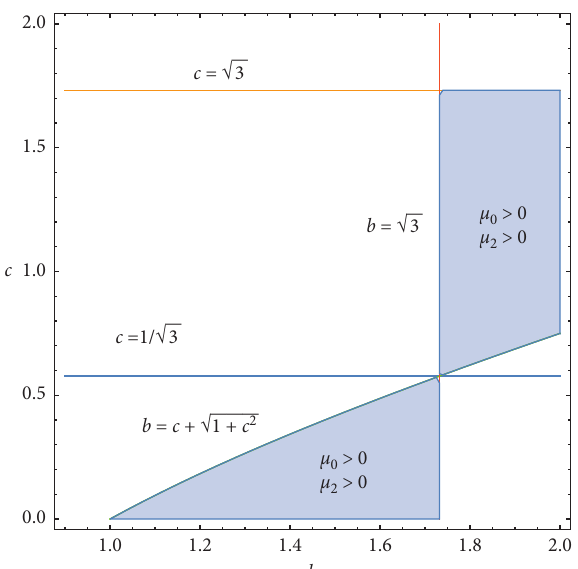
Figure 7: Region of existence of central configuration for the concave kite four-body configuration where m